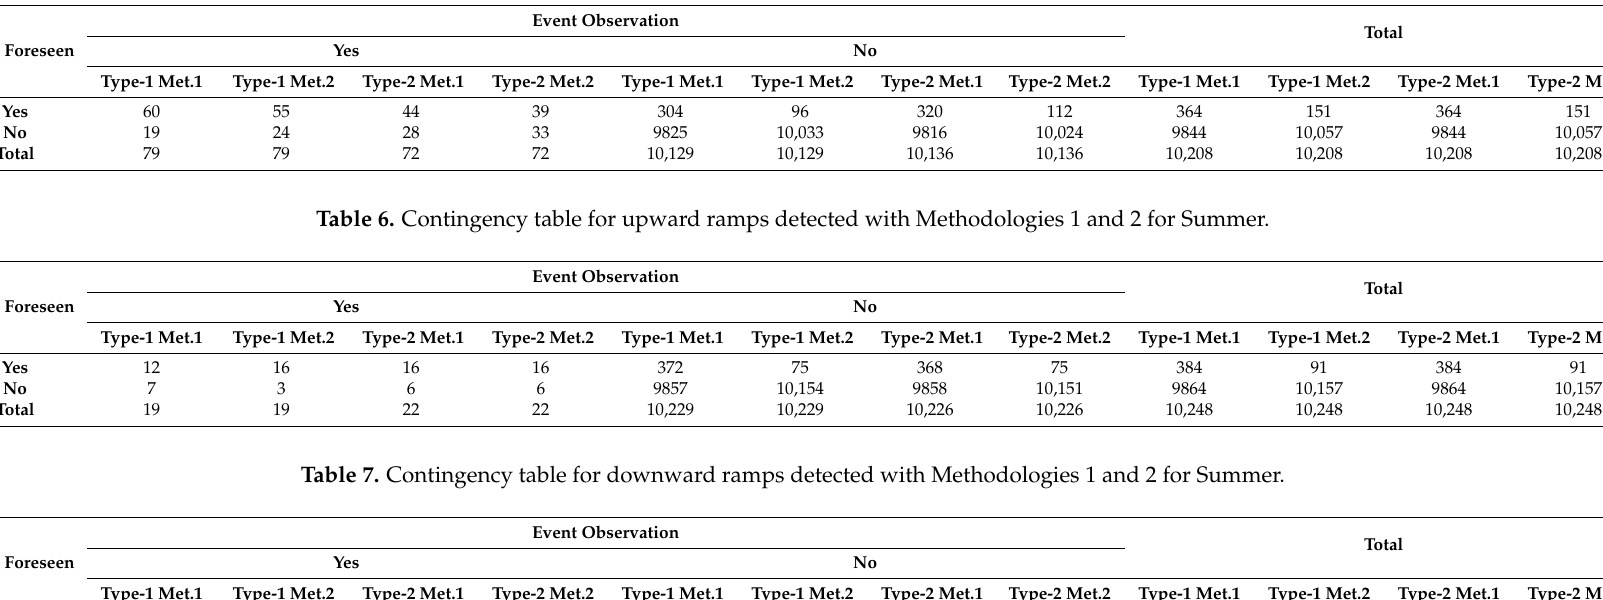
Table 5. Contingency table for downward ramps detected with Methodologies 1 and 2 for Winter.